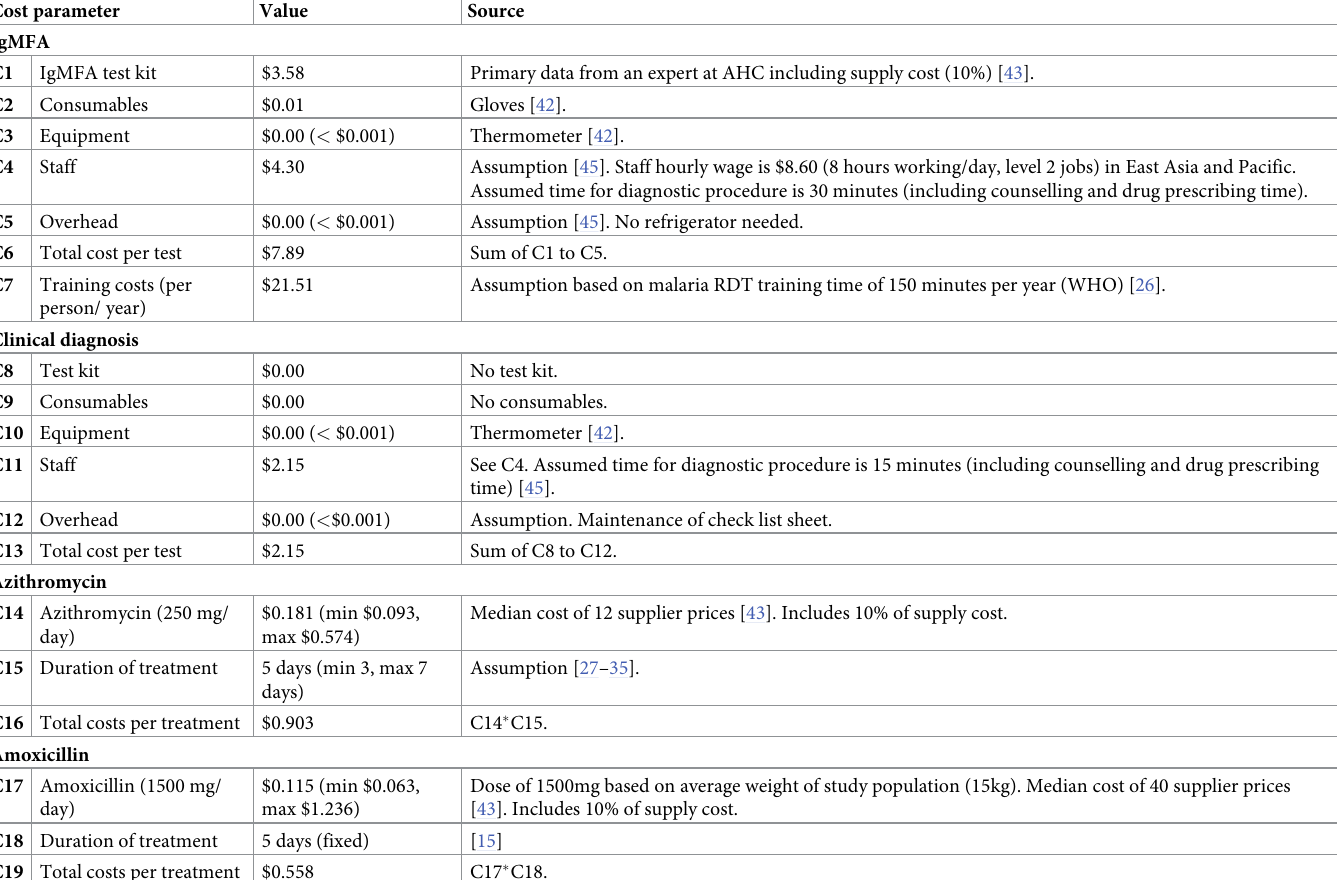
Table 2. Cost parameters in base-case analysis (presented in US$,